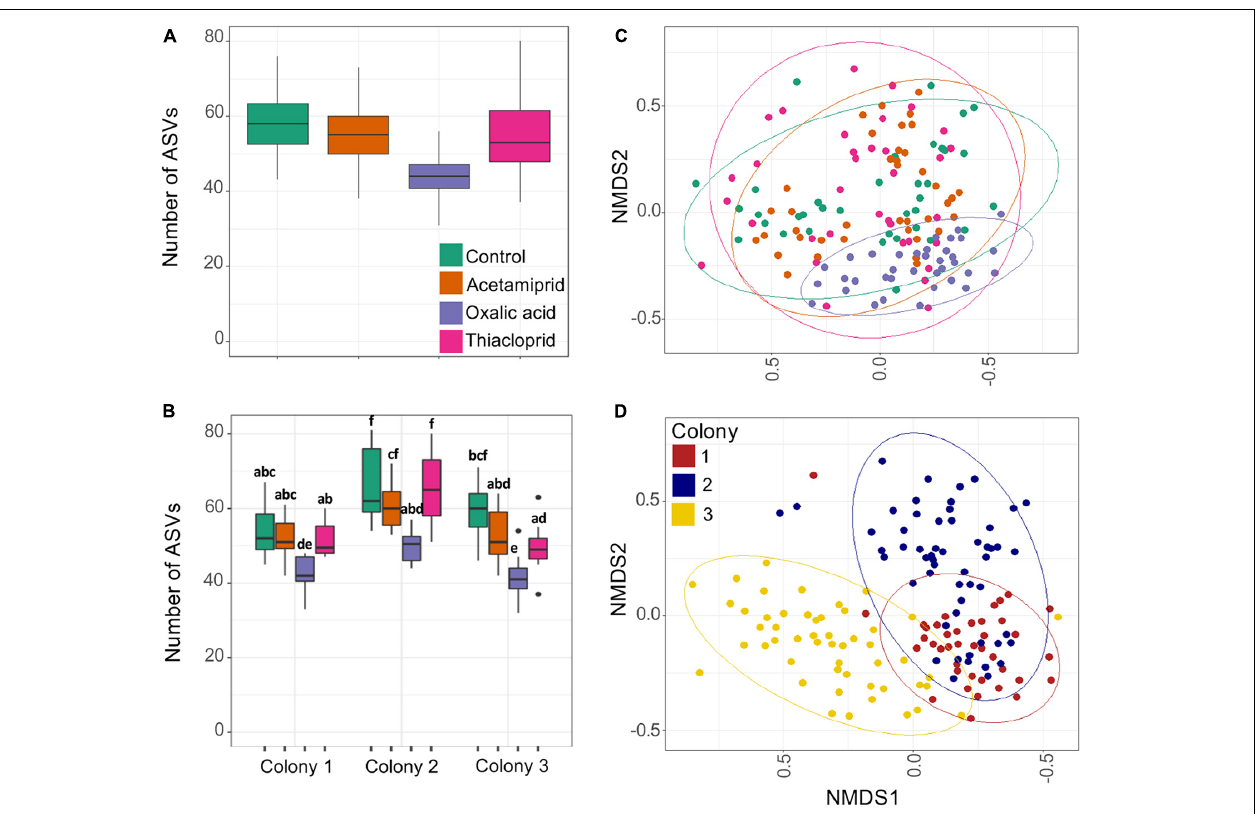
FIGURE 4 | Gut microbiome richness and beta diversity estimates of pesticide treated and control honeybees. (A) ASV richness across treatments. (B) ASV richness across colonies and treatments. Boxplots represent the first and third quartiles of the number of ASVs observed per treatment, the horizontal line represents the median, whiskers extend 1.5 interquartile ranges and dots represent outliers. In panel (B) , the letters represent the statistical dissimilarities across groups according to Tukey HSD test ( p < 0.05). (C) Non-metric multidimensional scaling (NMDS) analysis of the samples based on Bray–Curtis distances; plot ordination based on treatment. (D) Non-metric multidimensional scaling (NMDS) analysis of the samples based on Bray–Curtis distances; plot ordination based on colony. There is a clear clustering of the samples in the ordination plot based on colonies, which is supported by the PERMANOVA